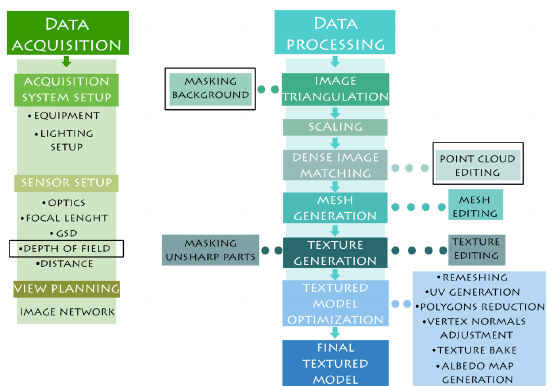
Figure 1. A schematic photogrammetric pipeline (acquisition and processing) for the production of textured 3D models. The steps discussed in this paper are shown in